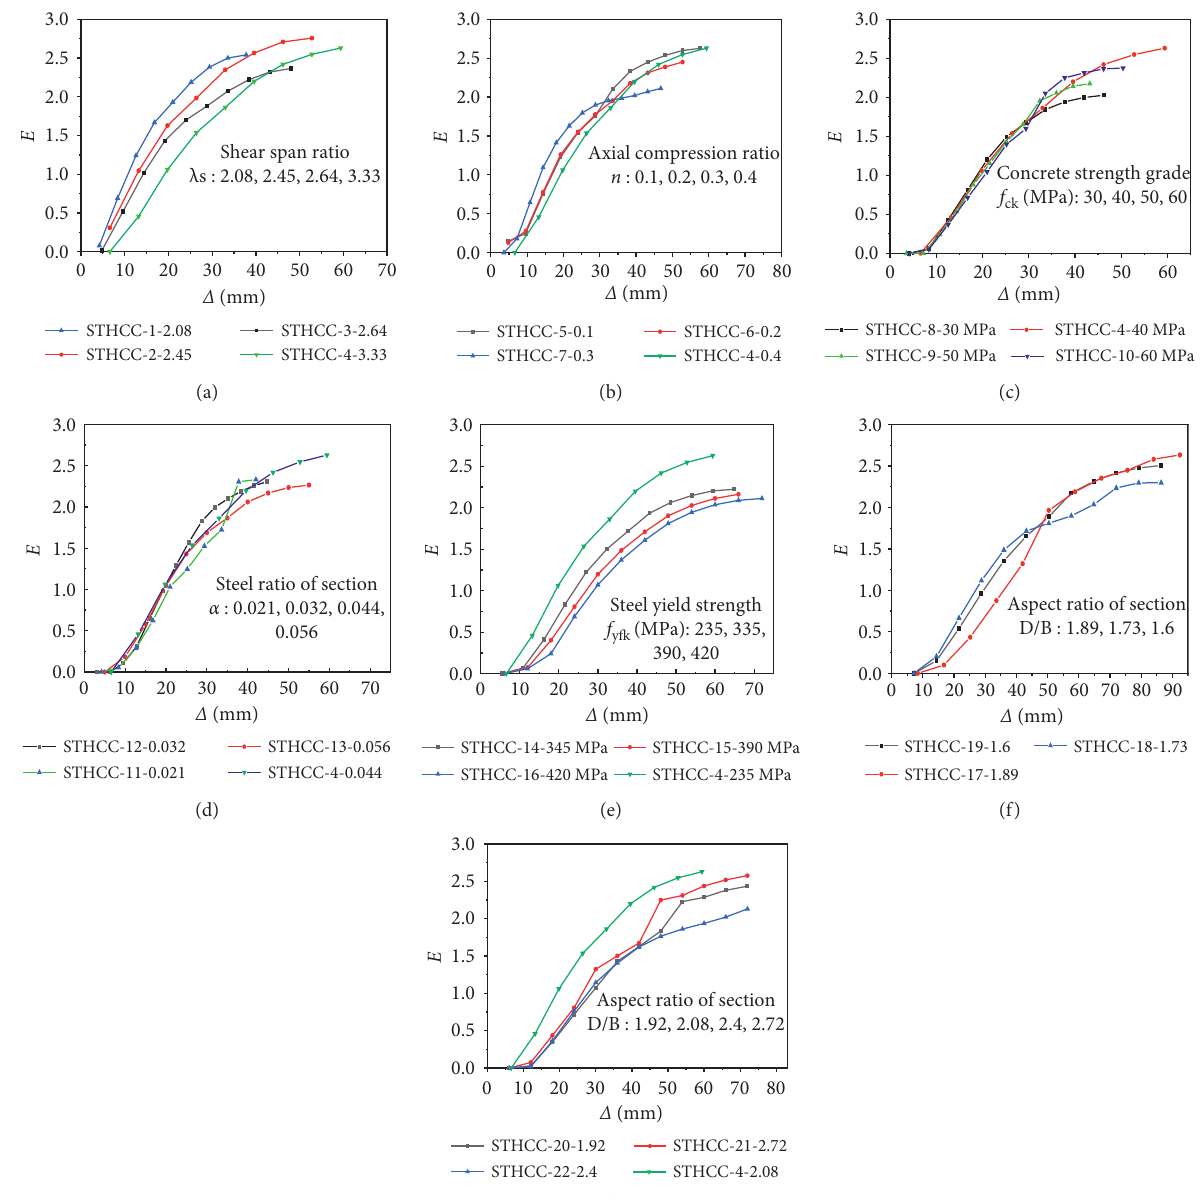
Figure 22: The relationship between E and Δ for STHCCs with different parameters. (a) λ 30MPa, 40MPa, 50MPa, 60 MPa. (d) α : 0.021, 0.032, 0.044, 0.056. (e) f yfk : 235MPa, 335MPa, 390MPa, 420MPa. (f) D / B :1.89, 1.73, 1.6. (g) D / B : 1.92, 2.08, 2.4,